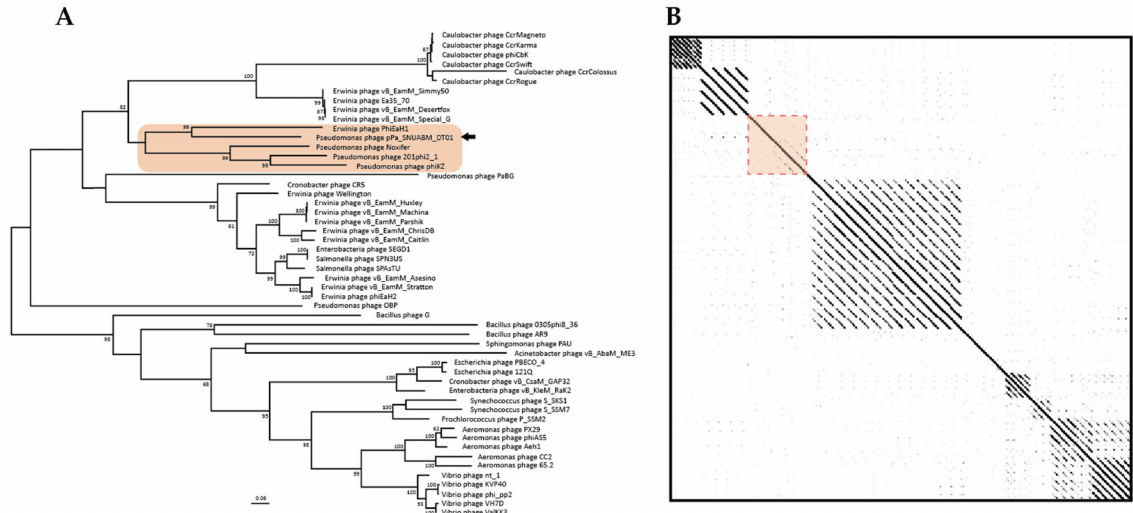
Figure 5. Conserved gene (major capsid protein) comparison of pPa_SNUABM_DT01 and jumbo-phages. Orange box: the cluster including pPa_SNUABM_DT01. ( A ) Phylogenetic tree constructed using MEGA-X by maximum-likelihood with major capsid protein sequences of pPa_SNUABM_DT01 and jumbo-phages. ( B ) Dot plot constructed with concatenated genome sequences used in phylogeny at a word size of